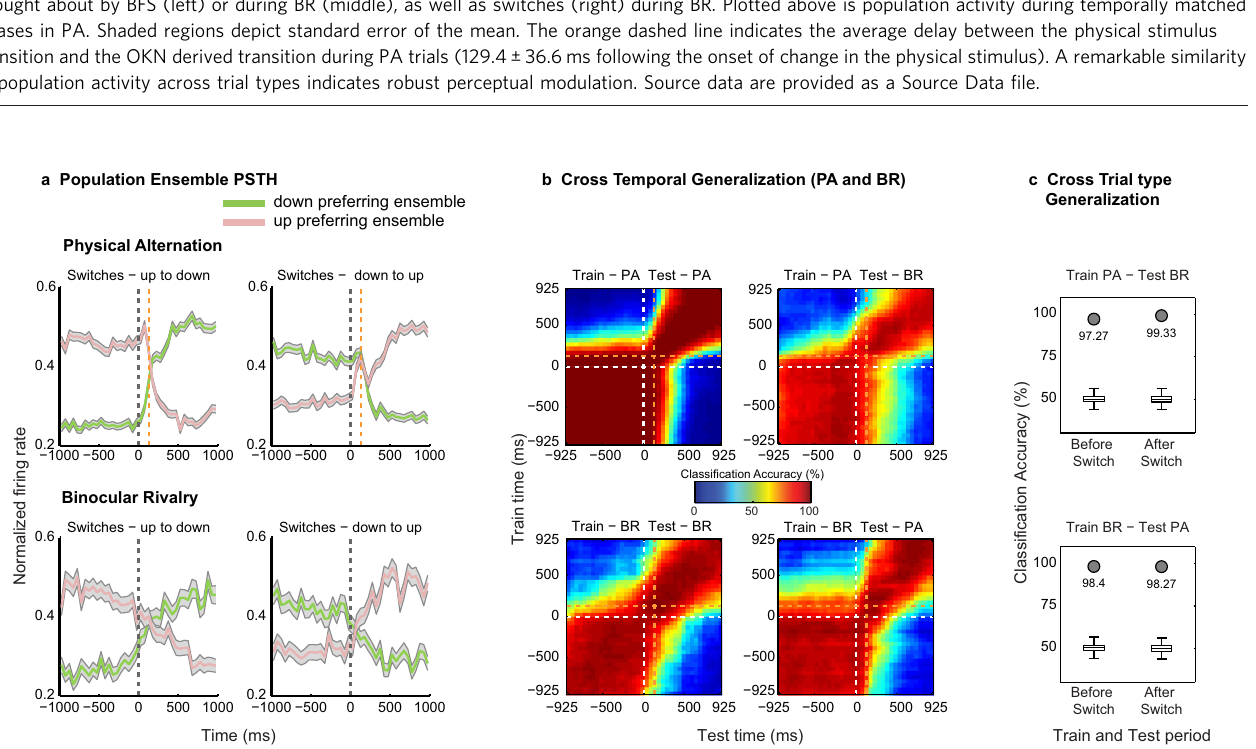
Fig. 3 Decoding the contents of conscious perception from simultaneously recorded prefrontal ensembles. a , Normalized population spiking activity of down (green) and up (pink) preferring ensembles during up to down or down to up, PA (upper row) and BR (lower row) switches shows reliable modulation. Data are presented as mean, and shaded regions depict standard error of the mean. b , Cross-temporal decoding of conscious contents around switches during PA and BR trials and generalization across the two. Classi fi cation accuracy was computed for each pair of train and test time windows (see methods) in steps of 50 ms, using 150 ms bins. In both a and b, the delay between the physical stimulus transition and the OKN derived transition during PA trials is indicated with an orange dashed line (129.4 ± 36.6 ms). c , Cross trial-type invariance of the population code assessed by training a classi fi er on activity during one trial type and testing on the other, before and after a switch for a single 400 ms bin (starting 200 ms pre and post switch). Box plots (for box plot description, see statistical information, methods) depict the distribution of classi fi cation results with shuf fl ed labels ( n = 500), while fi lled circles denote the highly signi fi cant (permutation test, one-sided, estimated p -value: p = 0.00199) classi fi cation accuracy with real labels. Results suggest invariance of the population code, thus encoding perceptual contents. The presented results were computed with data from two animals pooled together. Similar results were observed for individual animals, which are presented in supplementary fi gure 6. Source data are provided as a Source Data fi